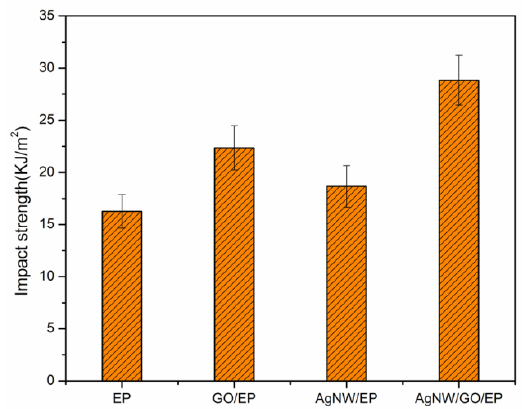
/ EP, AgNW / EP, and AgNW / GO / EP Figure 10. Impact strength of EP, GO/EP, AgNW/EP, and AgNW/GO/EP composites. Figure 10. Impact strength of EP, GO